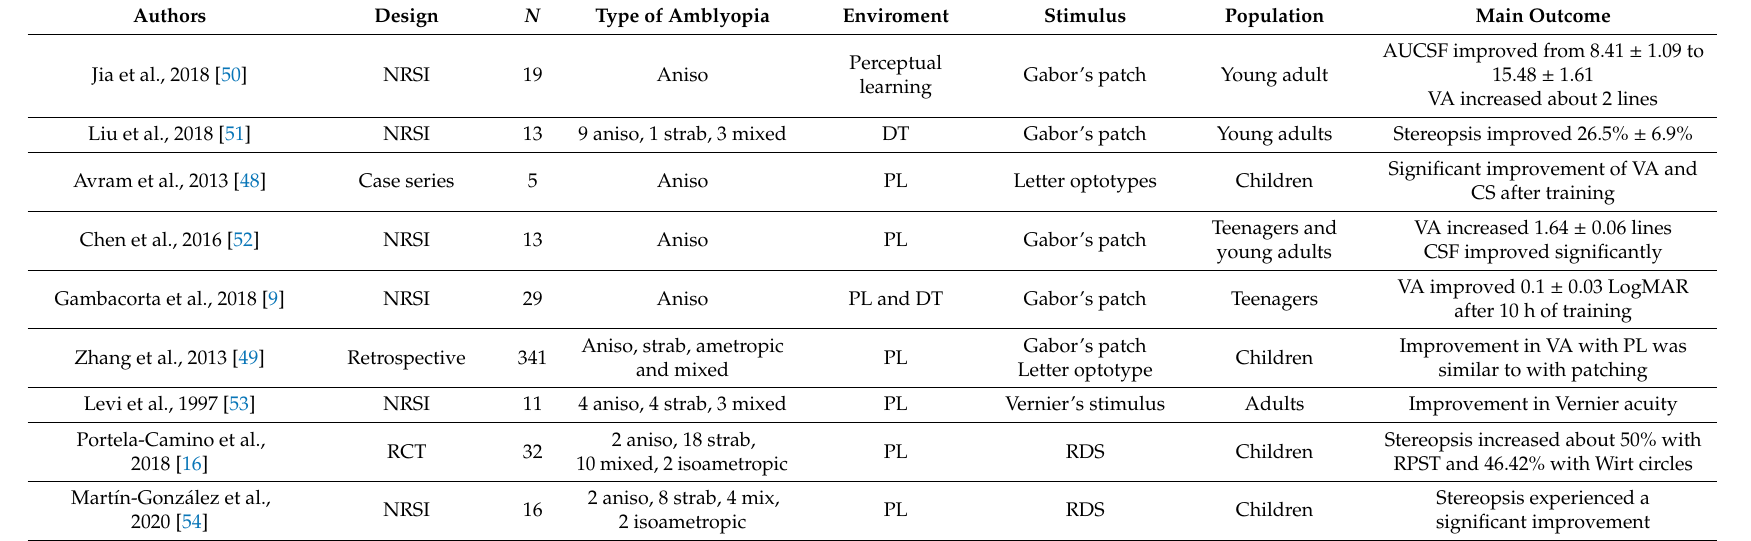
Table 1. Summary of the main outcomes obtained and the type of stimuli used in di ff erent clinical studies that have been revised in the current